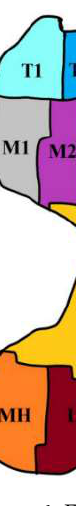
Figure 4. Foot divided into 12 regions for analysis of plantar pressure parameters: big toe (T1), second through fifth toes (T2, T3 and T45), metatarsals I–V (M1–M5), midfoot (MF), medial heel (MH), and lateral heel (LH).